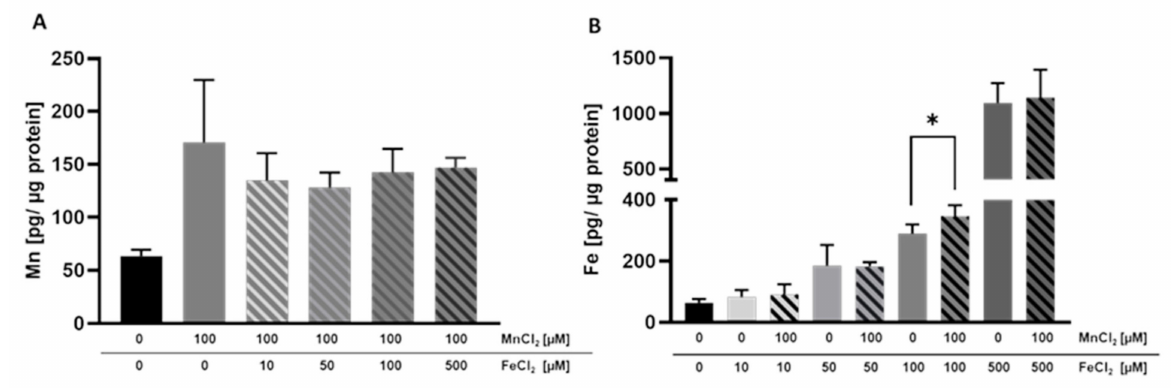
Figure 4. Mn and Fe bioavailability in BeWo b30 cells grown on inserts. BeWo b30 cells were incubated with MnCl 2 and/or FeCl 2 for 48 h, respectively. Total Mn or Fe amount was determined analytically using ICP-OES or ICP-MS/MS. ( A ) Mn amount [pg Mn/ µ g protein]. ( B ) Fe amount [pg Fe/ µ g protein]. Shown is the mean + SD of three independent experiments with two replicates each. Statistical analysis which is based on an unpaired t test is indicated as followed: *: compared to single TE